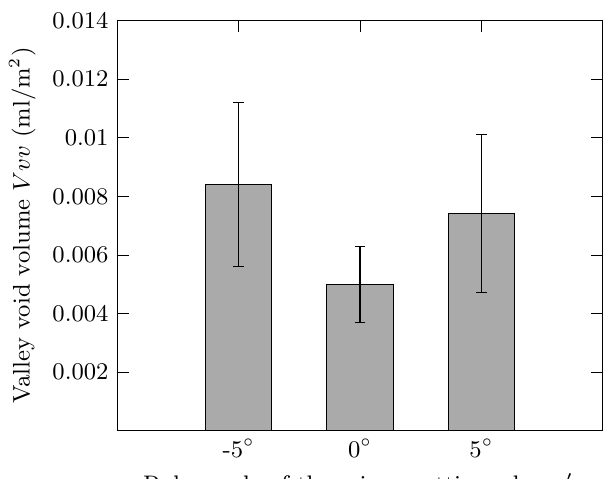
Figure 12. Valley void volume Vvv for different rake angles γ (cid:48) o of the minor cutting edge ( v c = 250m/min, f z = 0.015mm, a p = 0.25mm, a e = 0.5mm, α (cid:48) o = 2 ◦